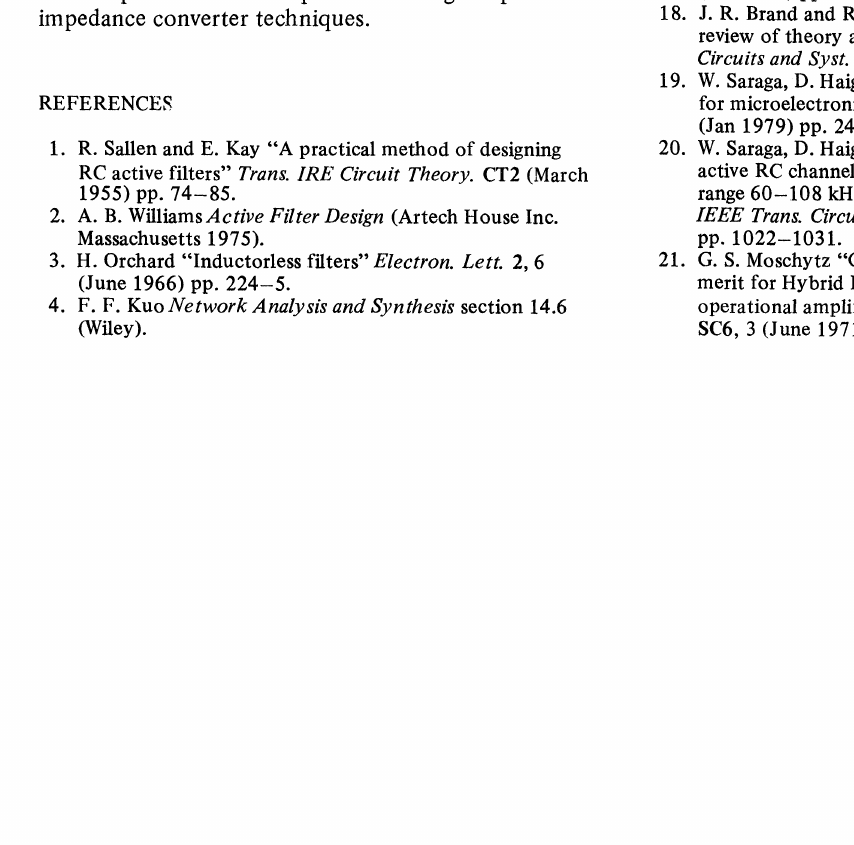
FIGURE 22 Thick film implementation of the five pole four zero elliptic filter using the P.I.C. circuit of Figure 19 (note this includes power supply decoupling